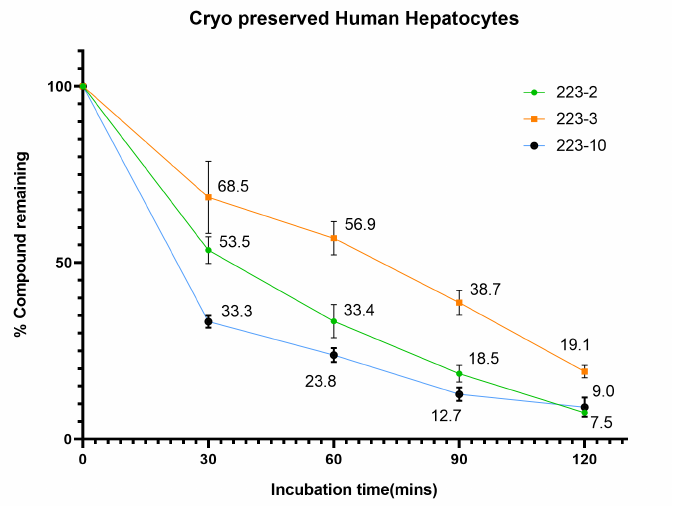
Figure 7. Metabolic stability studies of TbB ligands in hepatocytes—all three TbB ligands metabolized in cryopreserved hepatocytes (n = 3). Only <20% of the parent compound remained, suggesting that these ligands predominantly undergo Phase II metabolism or non-CYP pathways. Table 3. Intrinsic clearance studies with CPHH at test conc. of 1